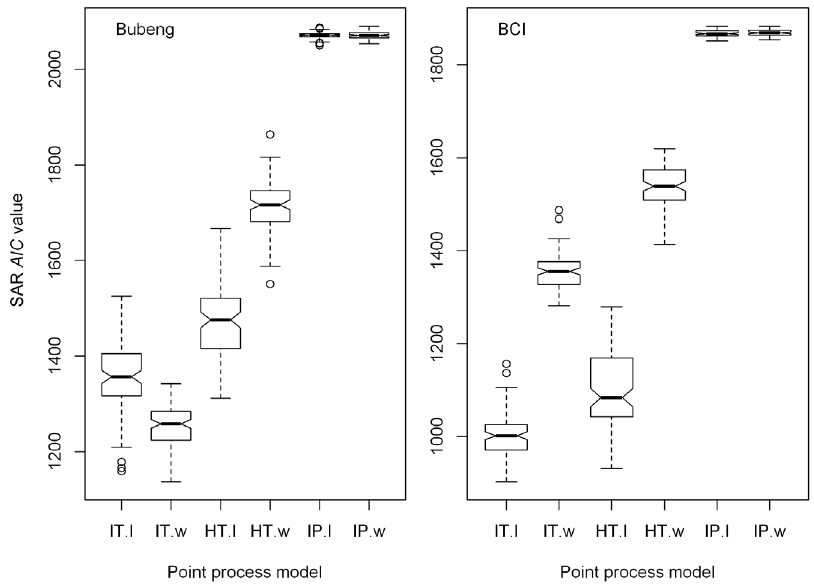
Figure 2. Boxplots of AIC value distributions of the SARs generated by the three process models with and without the size-class effect at Class 0 (that is: size-classes 1, 2 and 3 combined) forthe Bubeng plot and the BCI plot. HT.l=the homogeneous Thomas process with size-class effect; HT.w=the homogeneous Thomas process without size-class effect; IP.l=the inhomogeneous Poisson process with size-class effect; IP.w=the inhomogeneous Poisson process without size-class effect; IT.l=the inhomogeneous Thomas process with size-class effect; and IT.w=the inhomogeneous Thomas process without size-class effect.